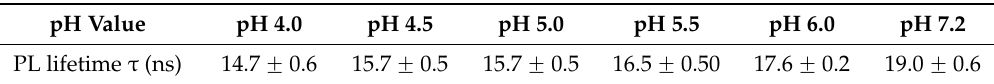
Figure 4. ( A ) Photoliuminescence spectra of the QDs water suspension of different pH values; and ( B ) PL lifetimes of QDs at different pH. Table 1. Mean photoluminescence (PL) lifetimes of quantum dots in water suspensions of different pH